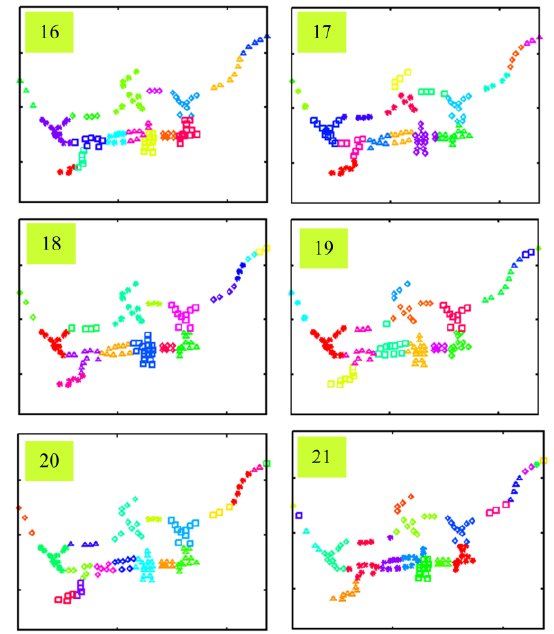
Figure 11. Clustering results for K inside interval [16, 21]